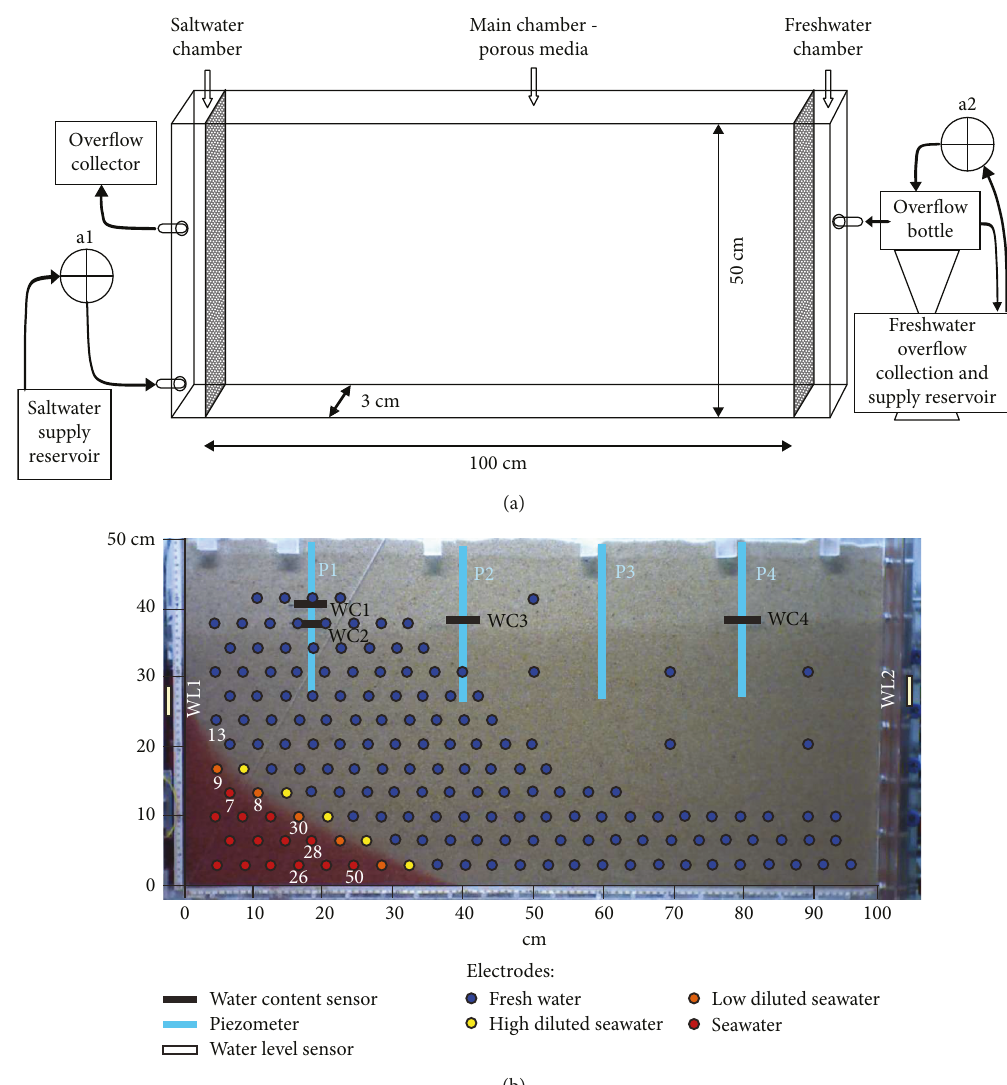
Figure 1: (a) The laboratory setup scheme. The main fl ow chamber simulates the aquifer, and the two side chambers create the boundary conditions during the experiments. The left chamber represents the saltwater boundary at the seaside, and the right chamber represents the inland freshwater boundary of the regional aquifer. (b) A picture of the laboratory aquifer. 168 electrodes are placed for in situ voltage measurements, which are equivalent to the salinity of the water. The electrodes, whose numbers are written, are discussed in the text. Four sensors of water content (WC1-WC4) are placed in the capillary zone above the water level. Four piezometers (P1-P4) are located a few centimeters below the water table at di ff erent distances from the left boundary. Two divers (WL1-WL2) are placed in the water